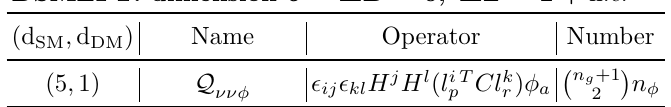
Table 16 . Dimension-six ∆ B = 0 , ∆ L = 2 operator in DSMEFT. The first column gives the dimensions of the SM and DM part of the operator, and the fourth column is the number of operators.